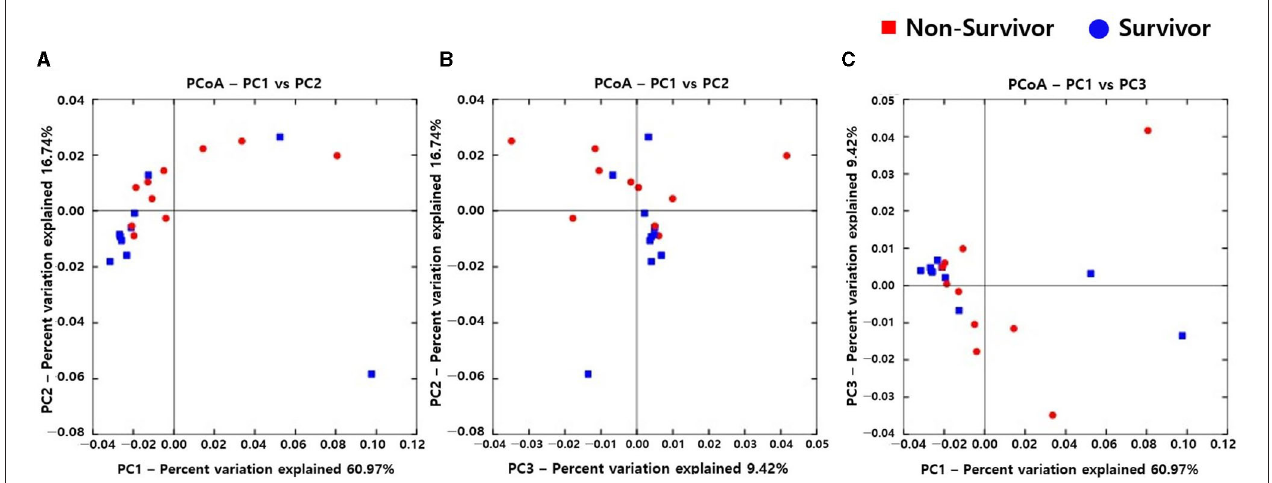
FIGURE 3 | Comparison of principal coordinates analysis outcomes using weighted UniFrac between non-survivors and survivors of IPF. Two-dimensional PCoA plots display inter-sample distances by three principal coordinates as PC1 and PC2 (A) , PC2 and PC3 (B) , and PC1 and PC3 (C) . Each dot represents one sample, plotted by a principal component on the X -axis and another principal component on the Y -axis, and colored by the group. The ratio (%) on each axis presents the contribution of values to discrepancies among samples. IPF, idiopathic pulmonary fibrosis; PCoA, principal coordinates analysis.